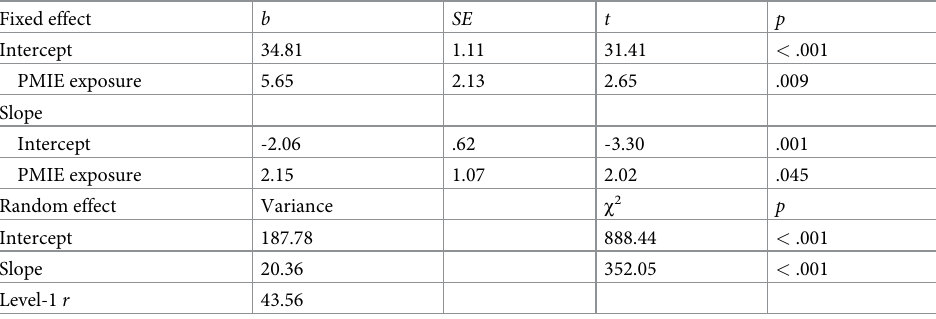
Table 3. Hierarchical linear model of the role of perceived transgression to self or other exposure on psychosocial functioning over the course of 10 months among healthcare providers during the COVID-19